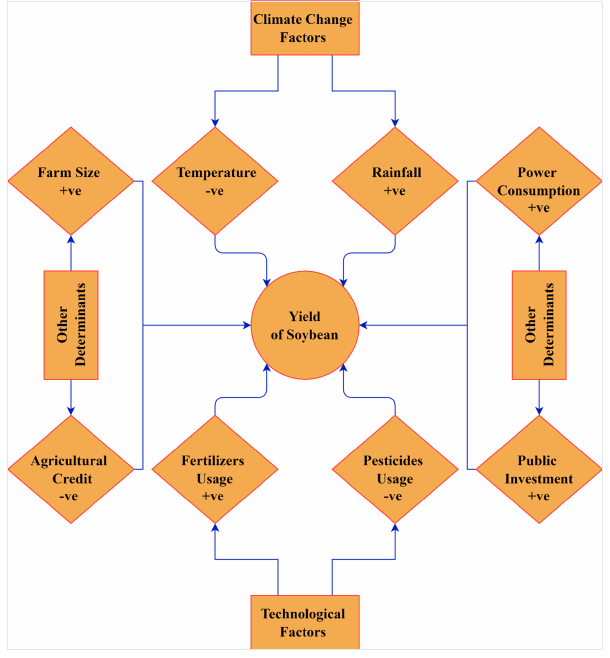
Figure 4. Summary of long-run estimates. “+ve” and “-ve” denote the positive effect and the nega- tive effect, respectivley.